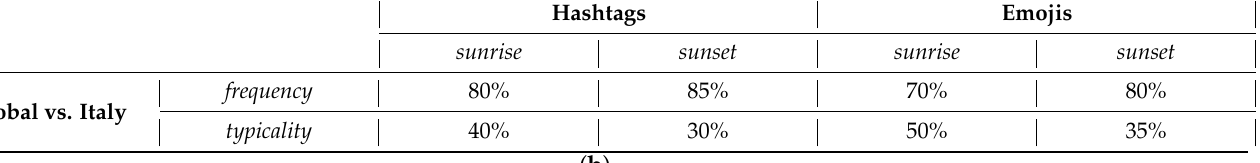
Table 2. (a) Percentage correspondence between the top 20 of sunrise- and sunset-related sub-datasets at the global and Italian levels. (b) Percentage correspondence between top 20 s of sub-datasets at the global and Italian levels. Hashtags Emojis frequency 80% 90% global typicality 5% 10% frequency Italy typicality ( a ) Hashtags Emojis sunrise sunset sunrise sunset frequency global vs. Italy typicality ( b